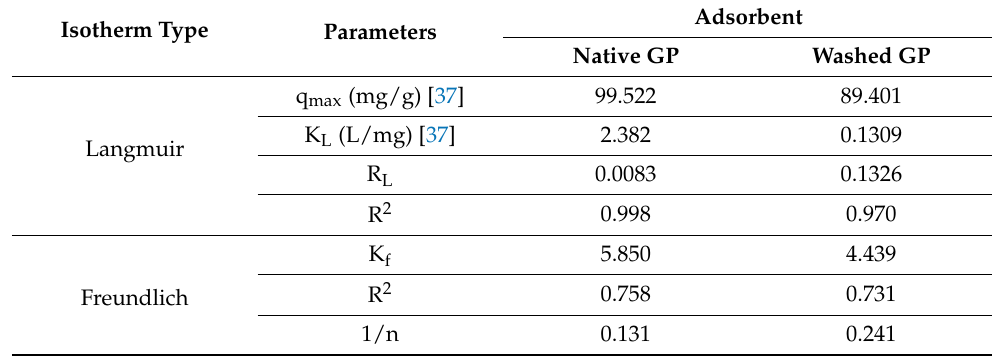
Table 4. Adsorption Isotherm studies for the adsorption of EBT onto native and washed GP. Isotherm